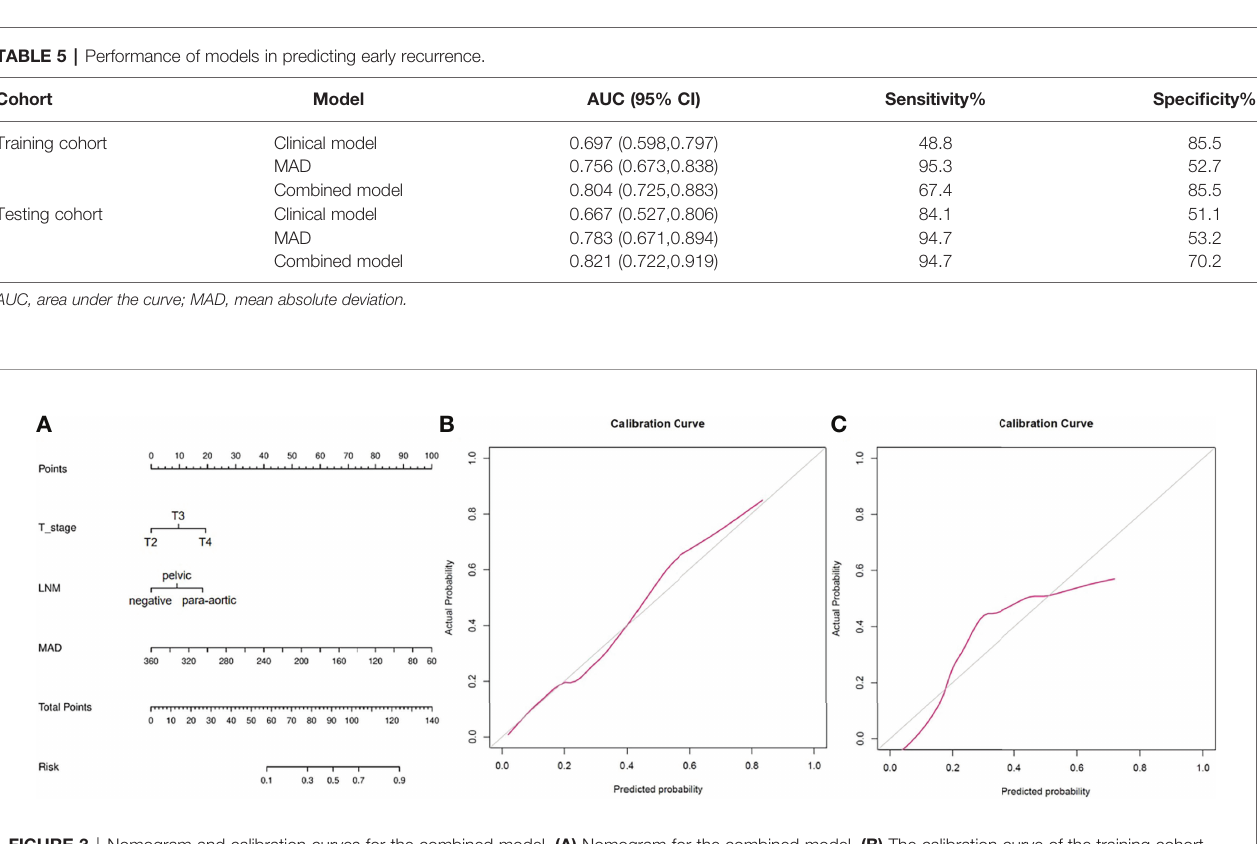
FIGURE 3 | Nomogram and calibration curves for the combined model. (A) Nomogram for the combined model. (B) The calibration curve of the training cohort. (C) The calibration curve of the testing